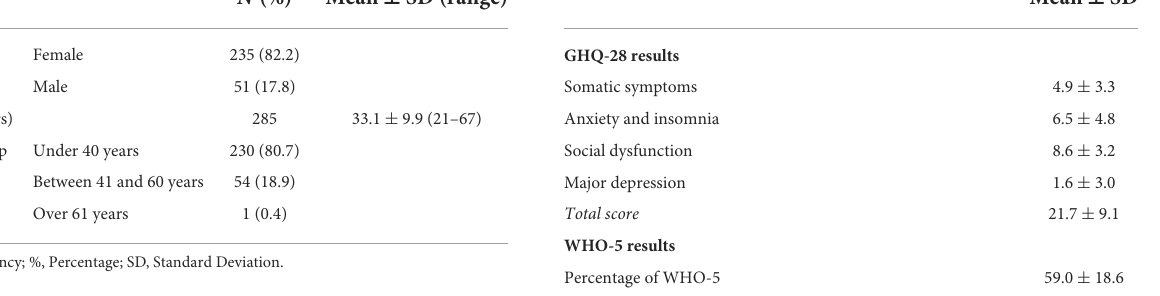
TABLE 1 Sample characterization.